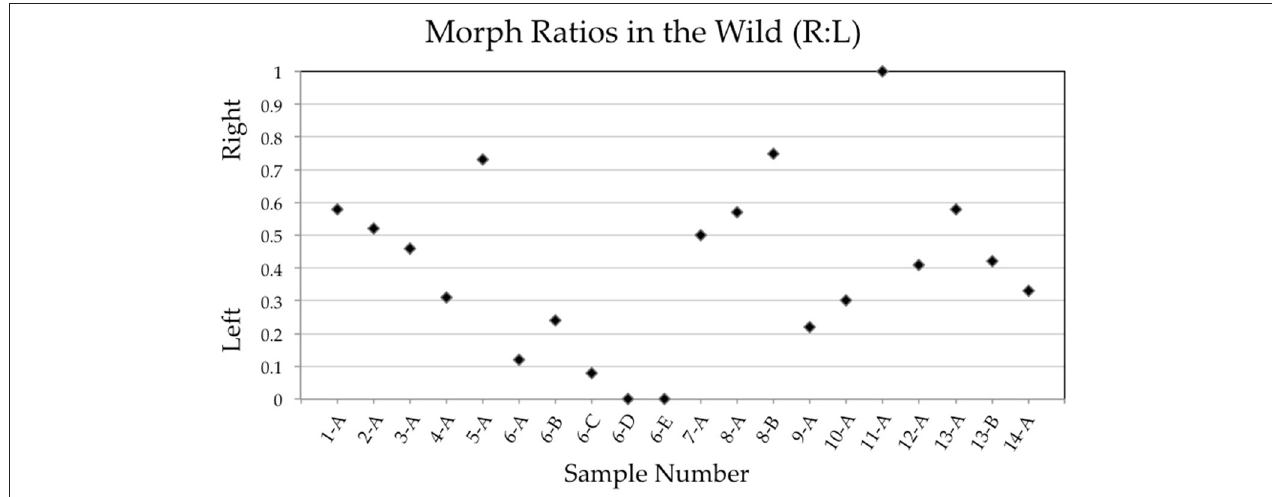
FIGURE 5 | Plot showing gonopodial morph ratios (right to left) of samples taken from wild populations between 1998 and 2019. Sample numbers correspond to those found in Table 1 . We only include samples here where the number of individuals scored was >